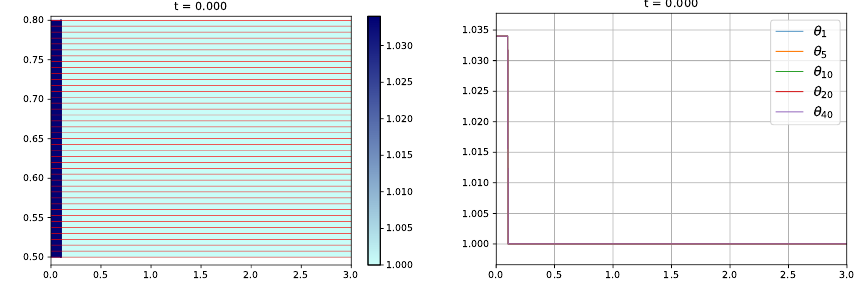
Figure 18. Initial